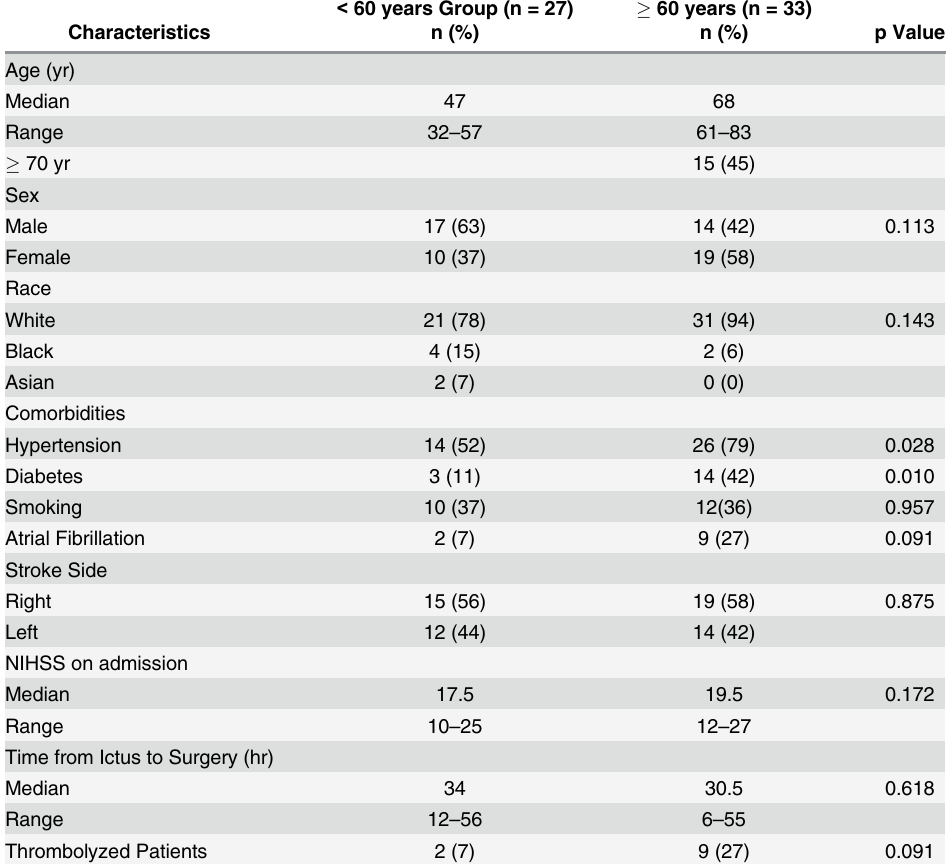
Table 2. Demographic characteristics, comorbidities, stroke side, clinical status at admission and